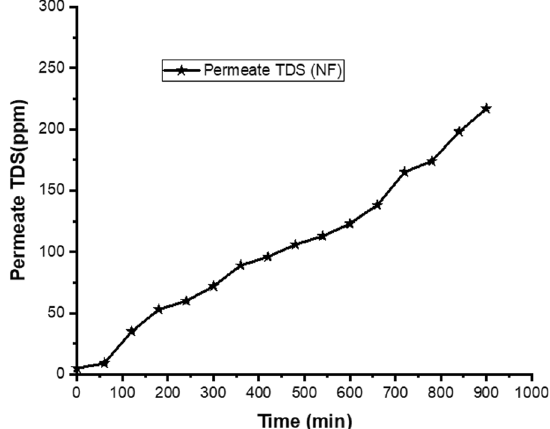
Fig. 9 Effect of NaOCl reaction time on flux and % TDS rejection of nanofiltration membrane